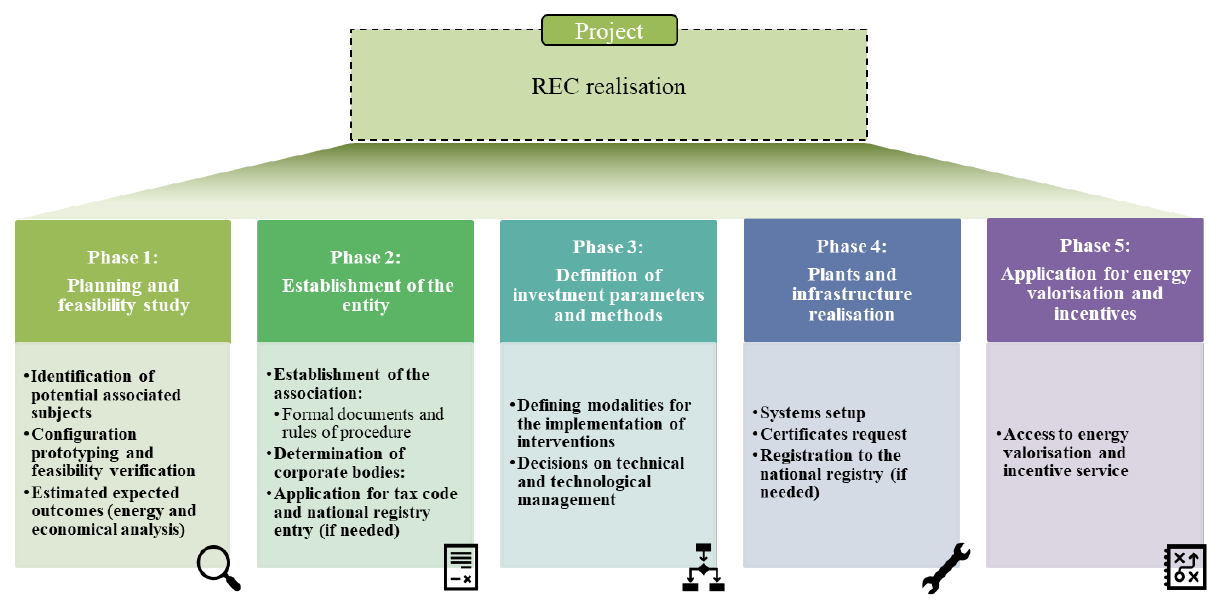
Figure 9. REC realisation process.